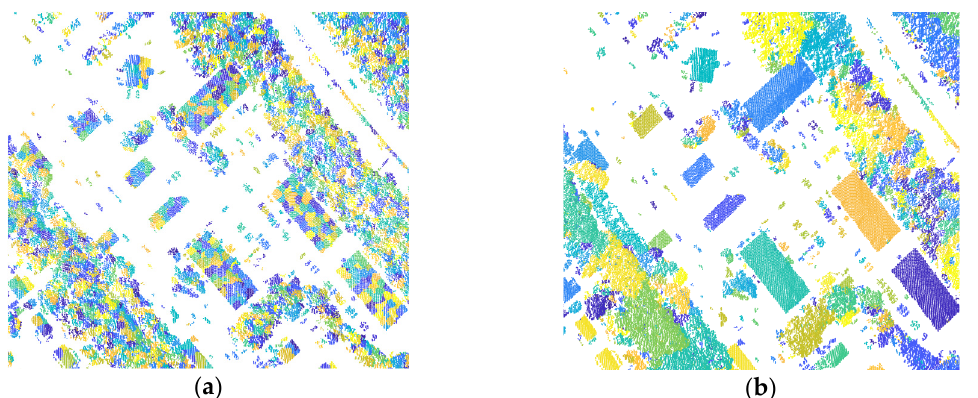
Figure 3. Results contrast between mean-shift algorithm and Algorithm 2: ( a ) Initial clusters achieved with mean-shift algorithm; ( b ) final clusters obtained by a post-processing step with constrained mean-shift algorithm.